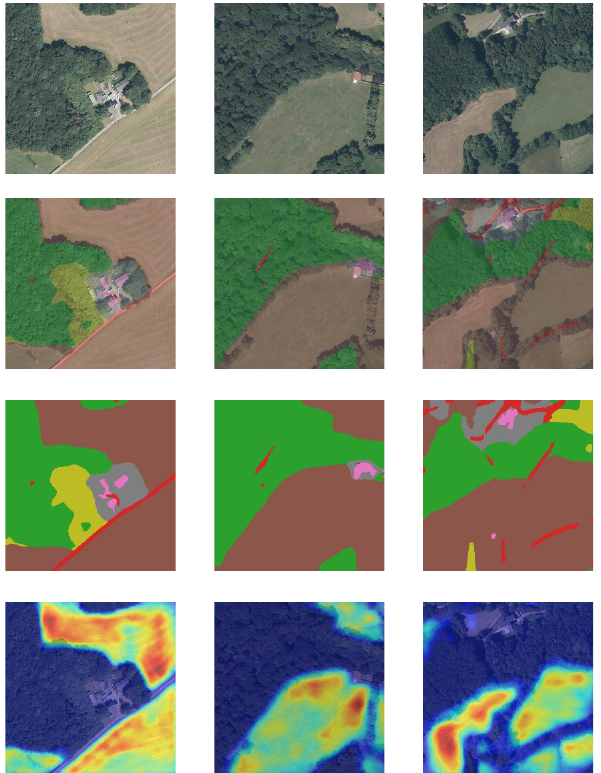
Figure 15. Semantic segmentation results. The first line is the original input image, the second line image and the third line image are the semantic segmentation image, the overlay effect image with the original input image, and the semantic segmentation image, respectively. The fourth line image is the attention heat map of the